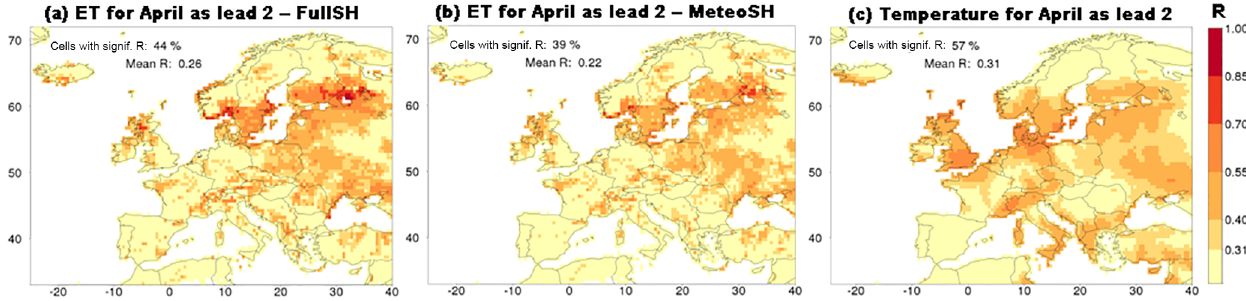
Figure 10. Explanation of the skill in the hindcasts of evapotranspiration, for target month April as lead month 2. The panels map the skill in evapotranspiration of the FullSHs (a) , of the MeteoSHs (b) and of the hindcasts of temperature (c) . For more explanation, see Fig. 1a.